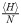
Critical thresholds of healthy cell populations.Loss of healthy tissue resulting in a second wave of damage, as a function of the parameters γ and β for fixed α = 5 (hours). Statistics are measured only for simulations where the cell population recovers and the red line shows γ/β = 1.69 (A). Average size of the minimum healthy population ⟨min(H)⟩ plotted against final length ⟨H⟩N (B). ⟨min(H)⟩ is now rescaled against the tissue length (N) and plotted against ⟨H⟩/N (C). ⟨min(H)⟩/N plotted with different lengths of initial damage (D).